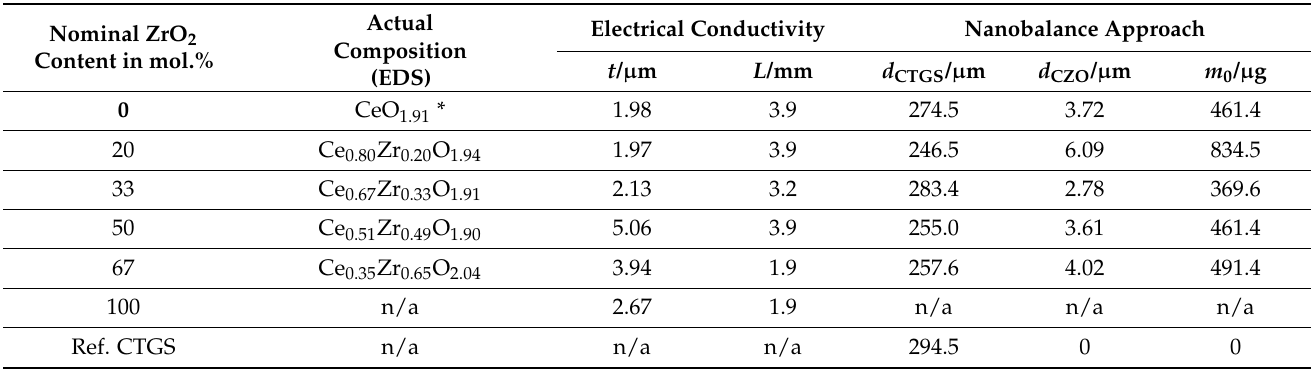
Table 1. Characteristics of Ce 1 − x Zr x O 2 − δ thin film